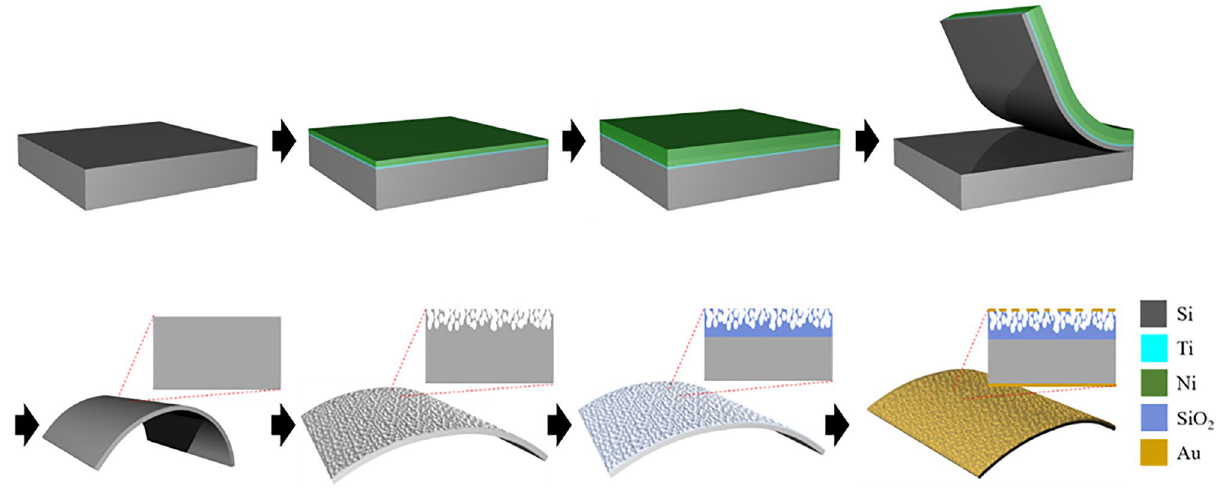
Figure 1. A schematic illustration of the fabrication of a freestanding bendable porous SiO 2 /Si film.